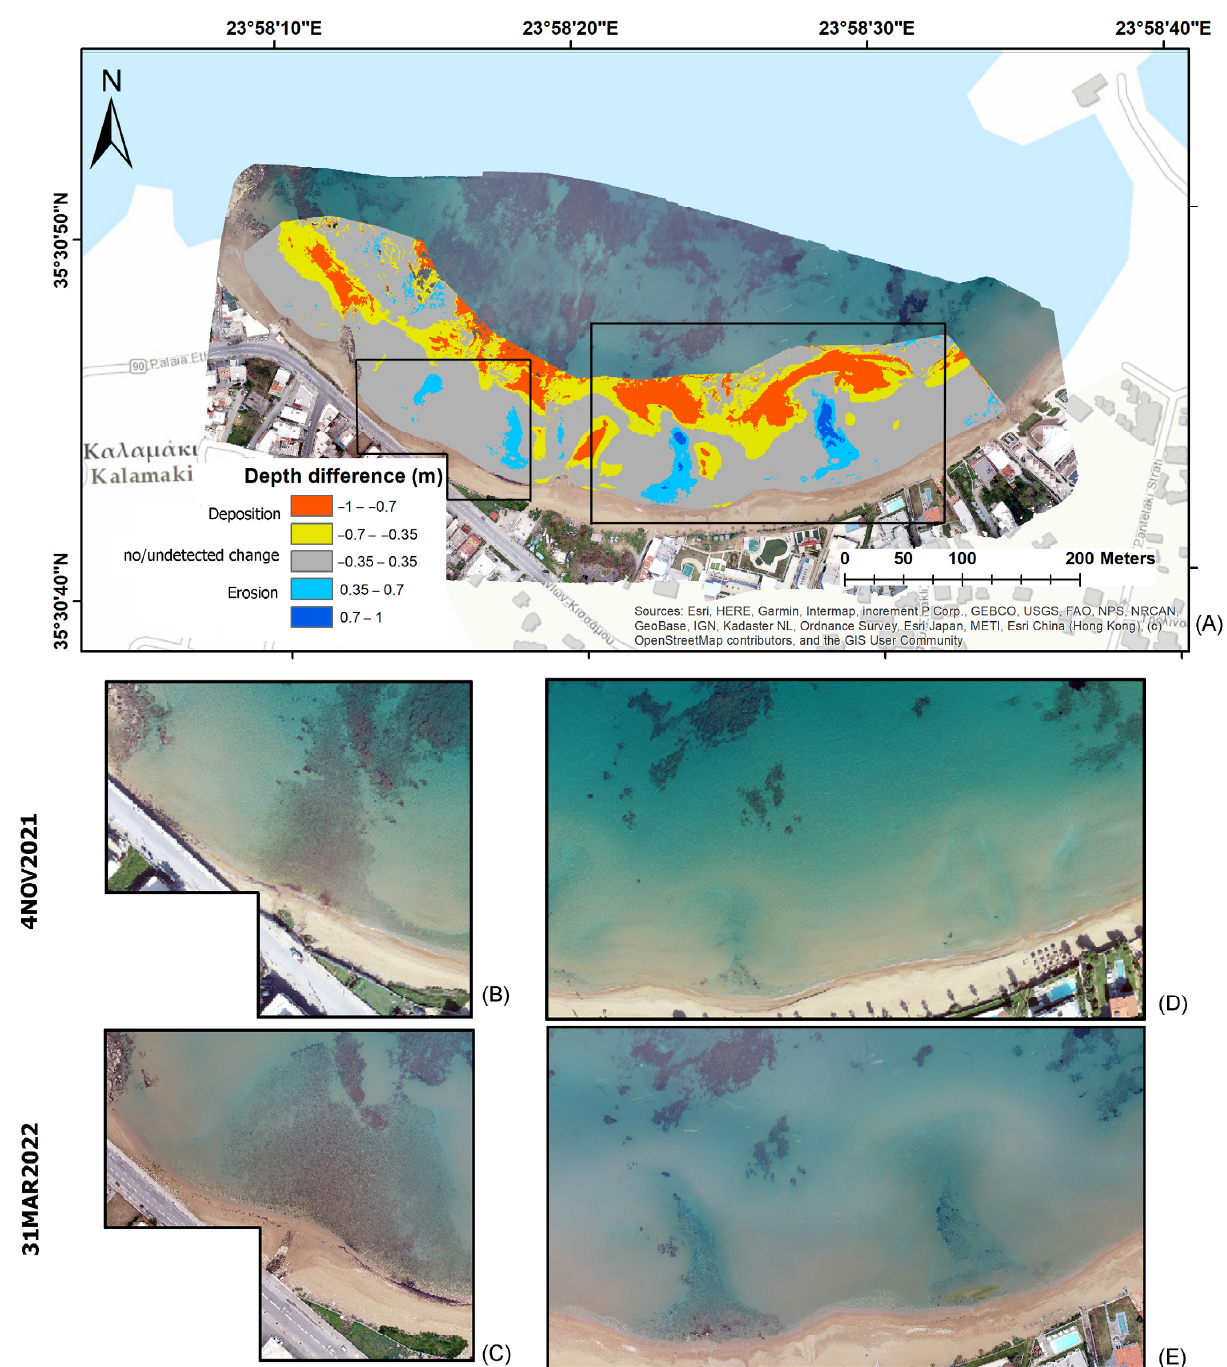
Figure 5. ( A ) Bathymetric difference map (November-2021 minus March-2022); ( B , C ) True-color orthomosaic subsets showing the temporal changes within the left polygon area; ( D , E ) True-color orthomosaic subsets showing the temporal changes within the right rectangle area.